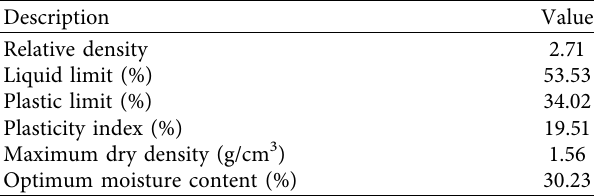
Table 1: Physical properties of laterite. Table 2: Properties of